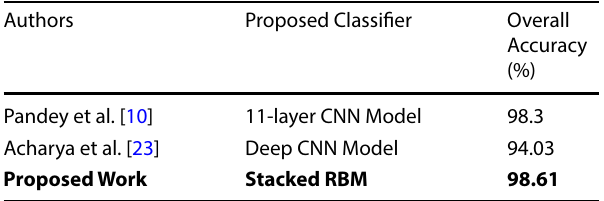
Table 3 Performance of other classifiers and our classifier on Patient Independent data